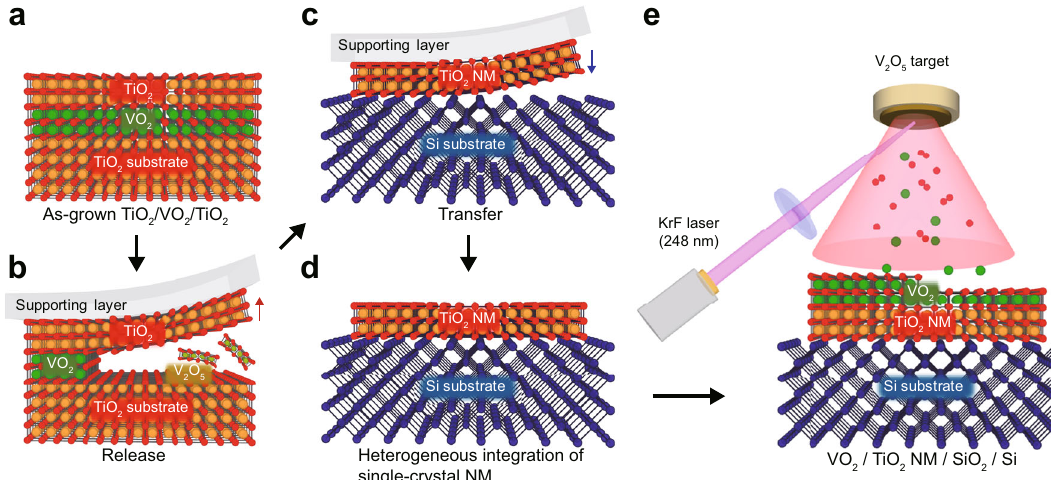
Fig. 1 Process schematic for single-crystal rutile oxide nanomembranes (NM) on silicon. a Schematic of an epitaxial TiO 2 /VO 2 heterostructure on TiO 2 host substrate. b The VO 2 layer is dissolved in H 2 O 2 to release the top TiO 2 fi lm with the mechanical supporting layer. c The freestanding TiO 2 NM is transferred onto the desired substrates (e.g., silicon). d By removing the rigid supporting layer, single-crystalline rutile oxide NM is heterogeneously integrated into a silicon substrate. e Epitaxial VO 2 fi lm with steep phase transition is grown on the TiO 2 -NM-templated Si